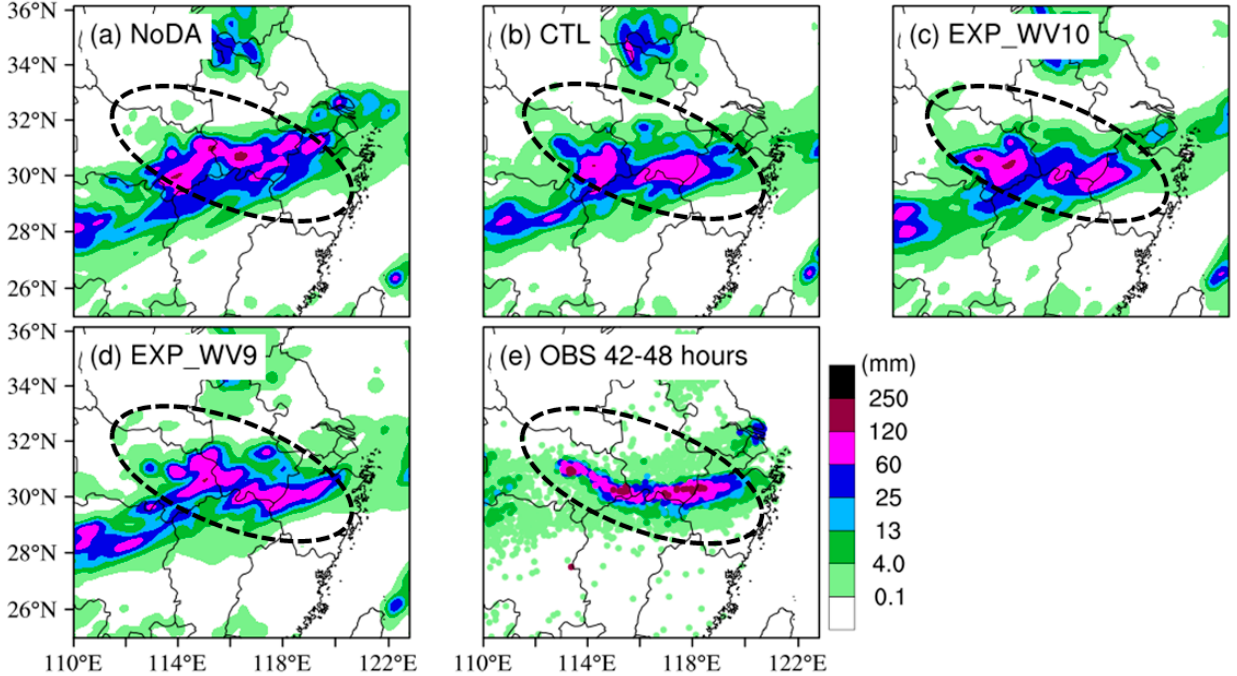
Figure 13. The 6 h accumulated precipitation from 1800 UTC 6 July to 0000 UTC 7 July 2020, for the forecast fields of the ( a ) NoDA, ( b ) CTL, ( c ) EXP_WV10, ( d ) EXP_WV9 experiments, and ( e ) observed 6 h accumulated rainfall.